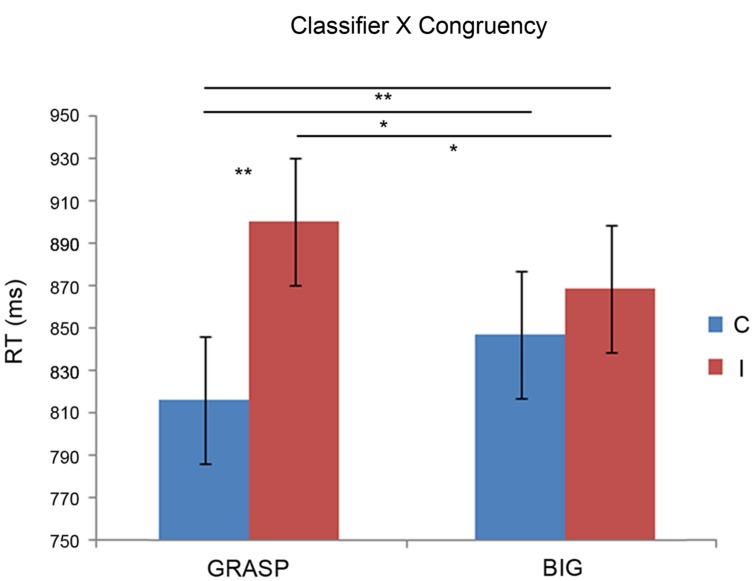
Mean reaction times (RTs) as a function of Classifiers and Congruency. Error bars represent 95% confidence intervals computed with the formula of Loftus and Masson (1994) for within-subject designs. Asterisks denote significant post hoc comparisons: *p < 0.05; **p < 0.005. C, congruent; I, incongruent.